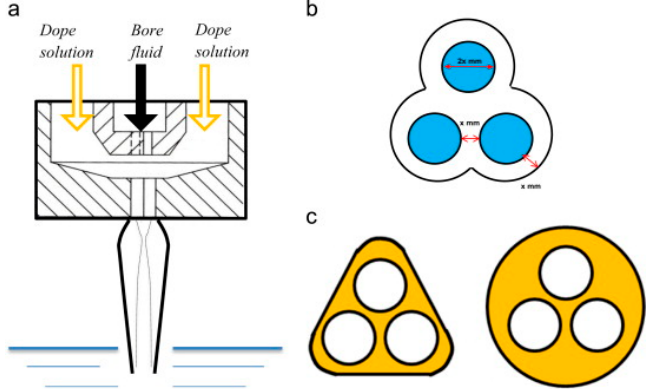
Figure 2. ( a ) Single layer tri-needle spinneret; ( b ) bottom view of the tri-needle spinneret; and ( c ) cross section [6].